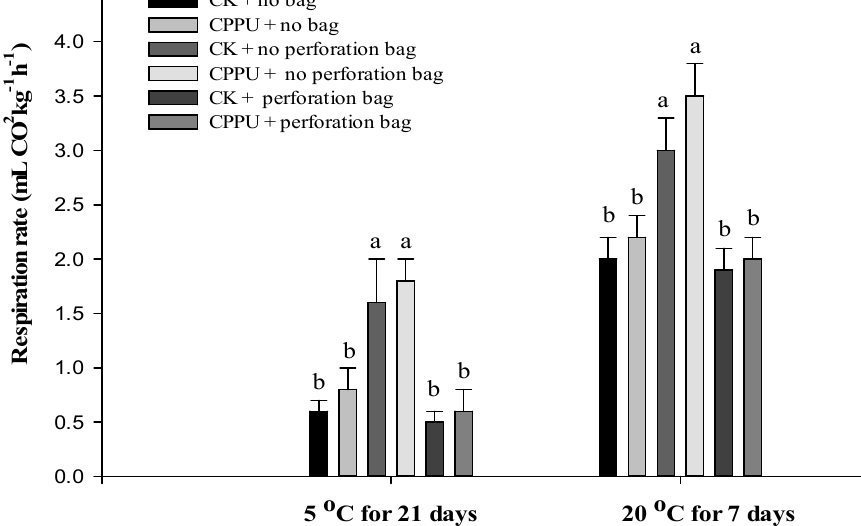
Figure 5. The effect of preharvest application of CPPU and perforation packaging on respiration rate of red-fleshed pitaya ‘Da Hong’ fruit at 5 °C for 21 days storage and transferred to 20 °C for 7 days. Bars represent means of ten replications ± SD ( n = 4). Means with different lowercase letters are significant differences ( p < 0.05).